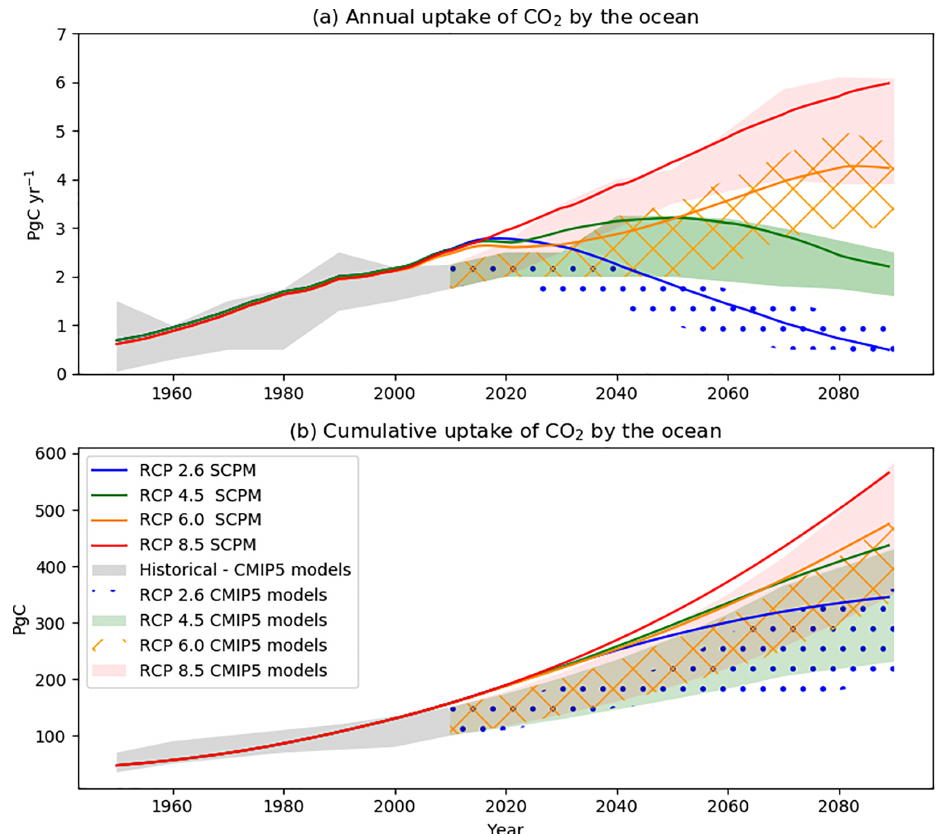
Figure 7. Panel (a) shows the annual uptake of CO 2 by the ocean in each of the RCPs over the period 1751–2100, modelled with SCP-M. By 2100, SCP-M estimates a range of 0–6PgCyr − 1 across the RCPs as estimated by CMIP5 models, reproduced from Jones et al. (2013). Panel (b) shows the cumulative uptake of CO 2 by the ocean over the same period modelled with SCP-M and compared with CMIP5 models (Jones et al., 2013).